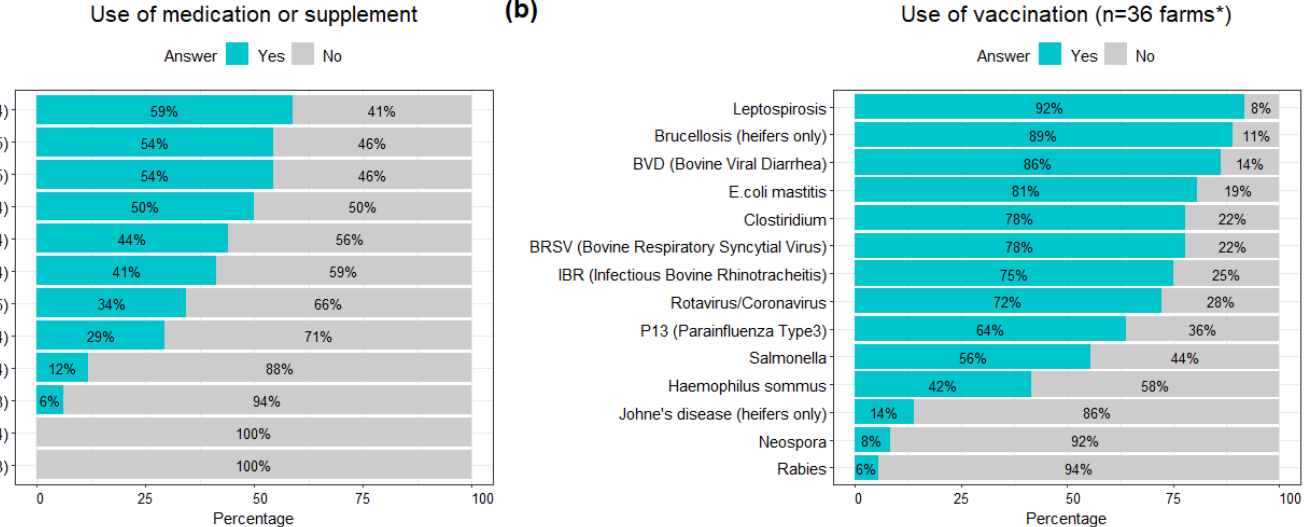
Figure 4. Use of medication or supplements ( a ) and vaccination ( b ) (n = 36 farms surveyed). * For the use of vaccination, respondents could select all that applied to them.